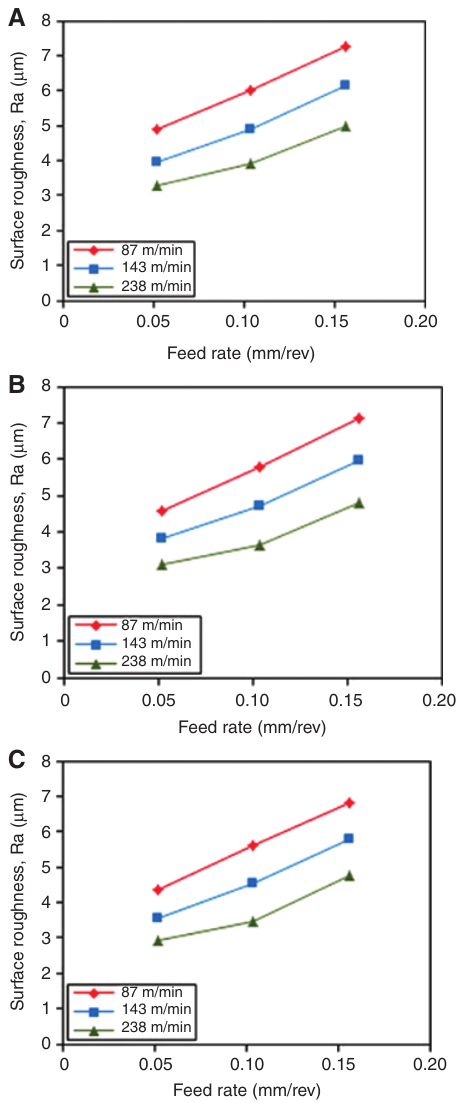
Figure 2 Effect of feed rate on surface roughness; tool radius: (A) r = 0.4 mm, (B) r = 0.8 mm, and (C) r = 1.2 mm.